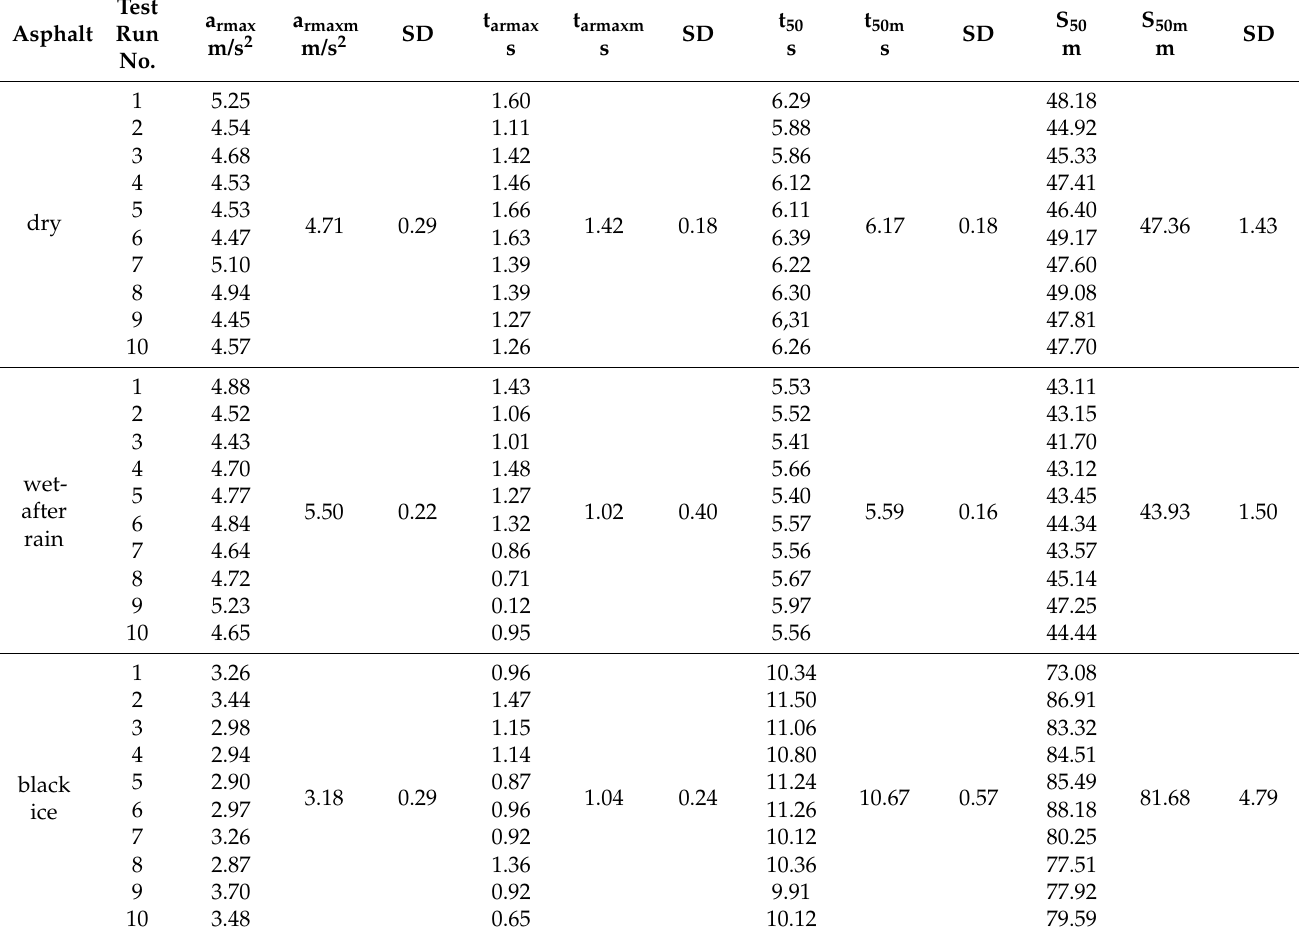
Table 9. The Ford Transit’s selected motion parameters during rapid acceleration on a dry surface, a wet (after rain) asphalt, and asphalt covered with a thin ice